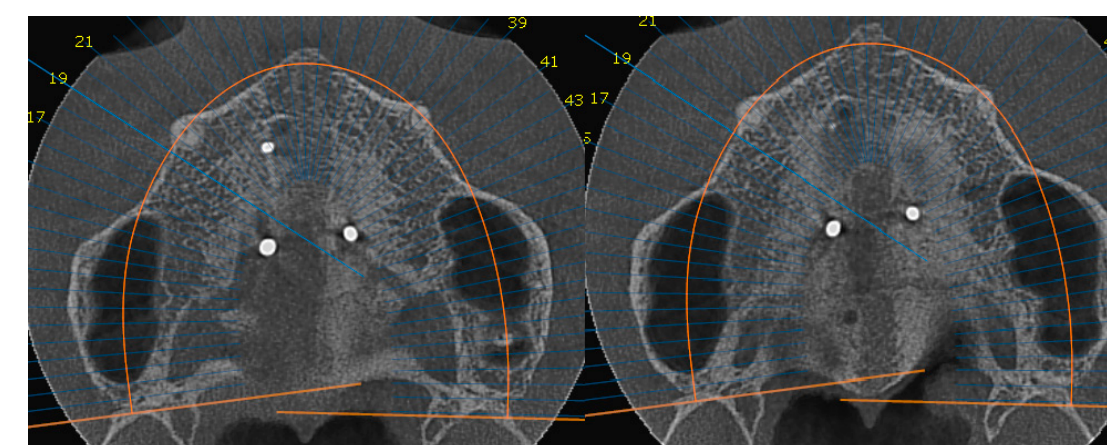
Figure 8. The split of the palatal suture.